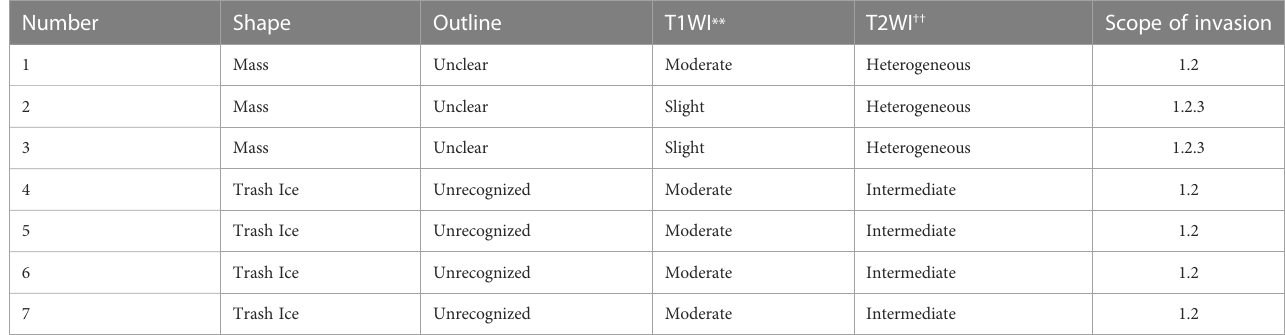
TABLE 3 MR fi ndings of the patients with STS-PLE.